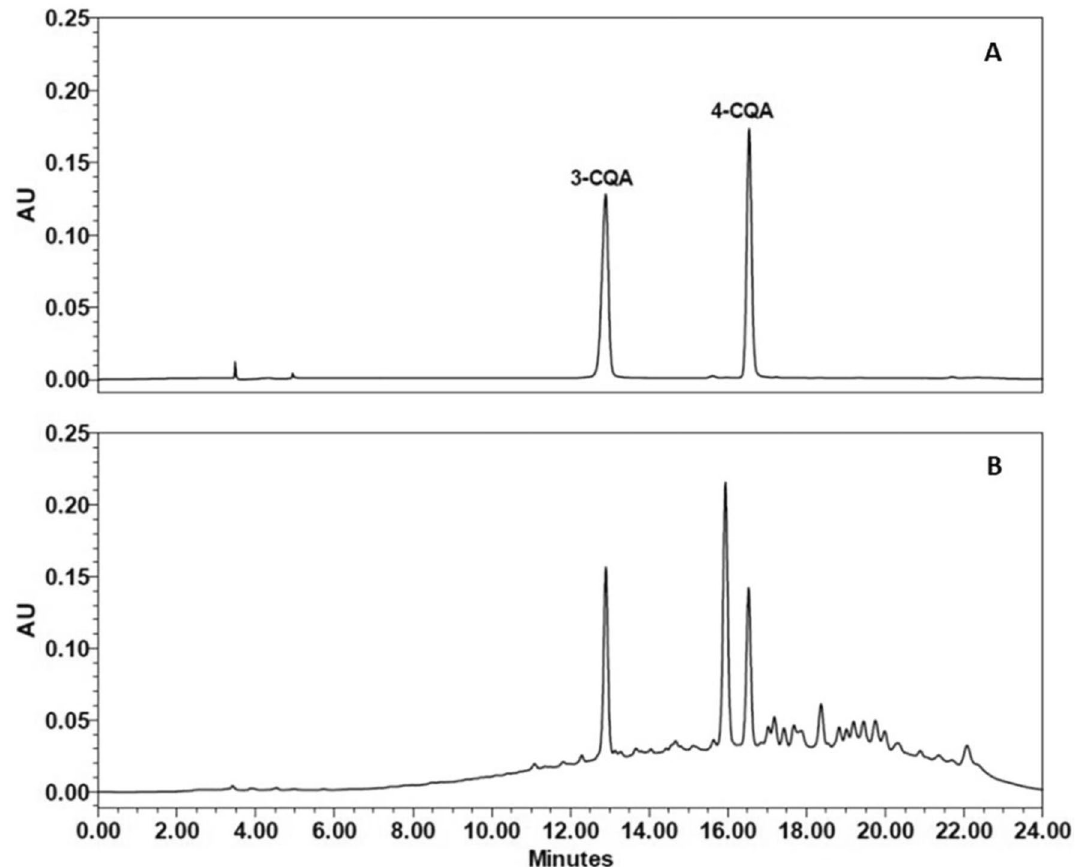
Figure 5. HPLC–DAD chromatograms of ( A ) mixed chlorogenic acid standards of 3- O -caffeoylquinic acid (3-CQA; t r = 12.883 min) and 4- O -caffeoylquinic acid (4-CQA; t r = 16.509 min), at a concentration of 50 ppm, and ( B ) F. dubia sap (FDS) extract (10 mg/mL). The peaks were detected at a wavelength of 330